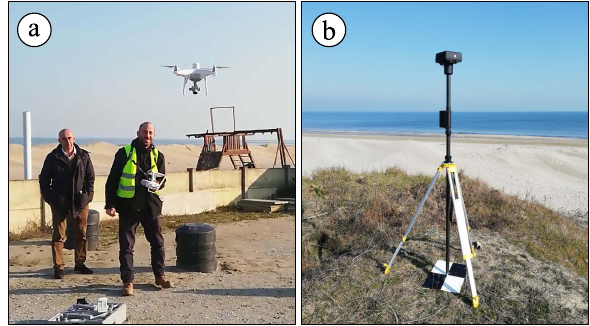
Figure 1. (a) DJI Phantom 4 RTK during landing operations; (b) The D-RTK 2 Mobile Station.